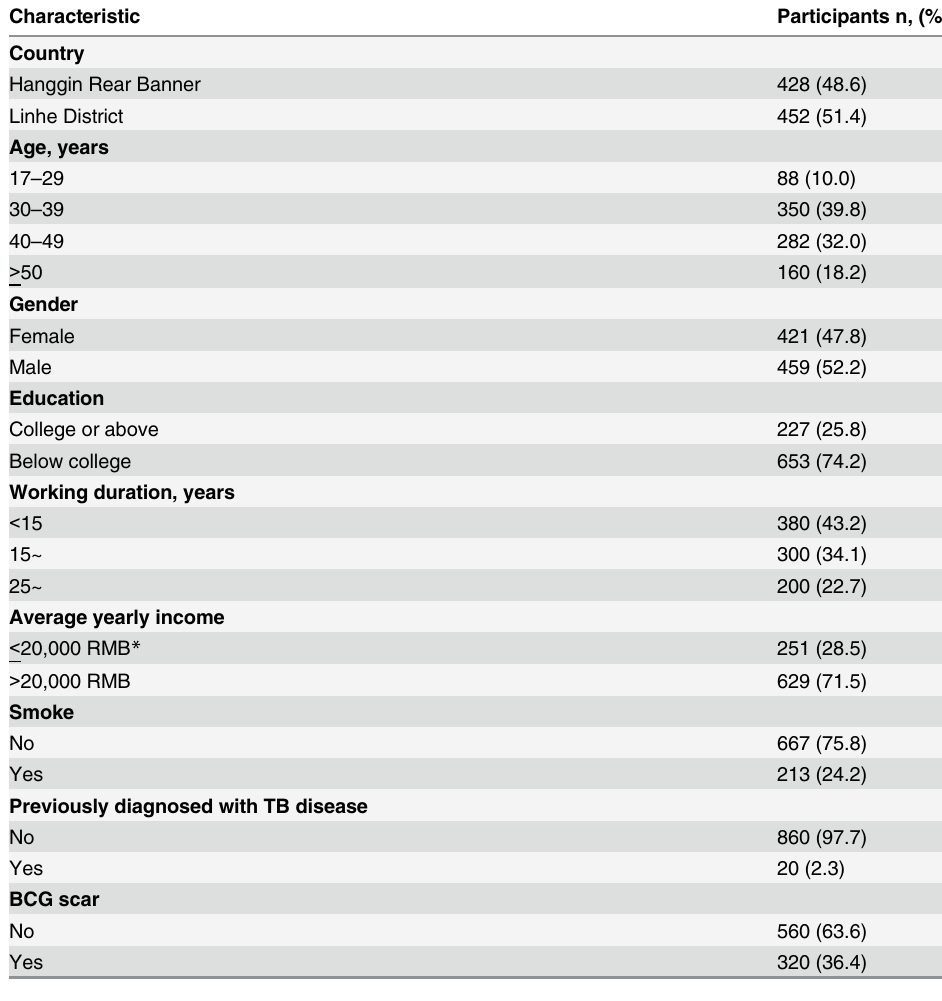
Table 1. Characteristics of 880 village doctors in